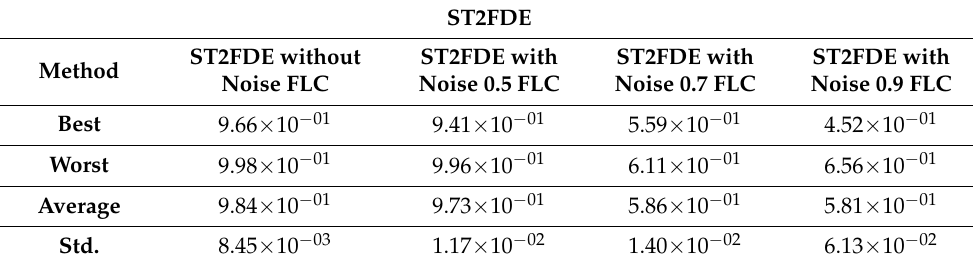
Table 5. Comparison of results using ST2FDE optimization of the fuzzy